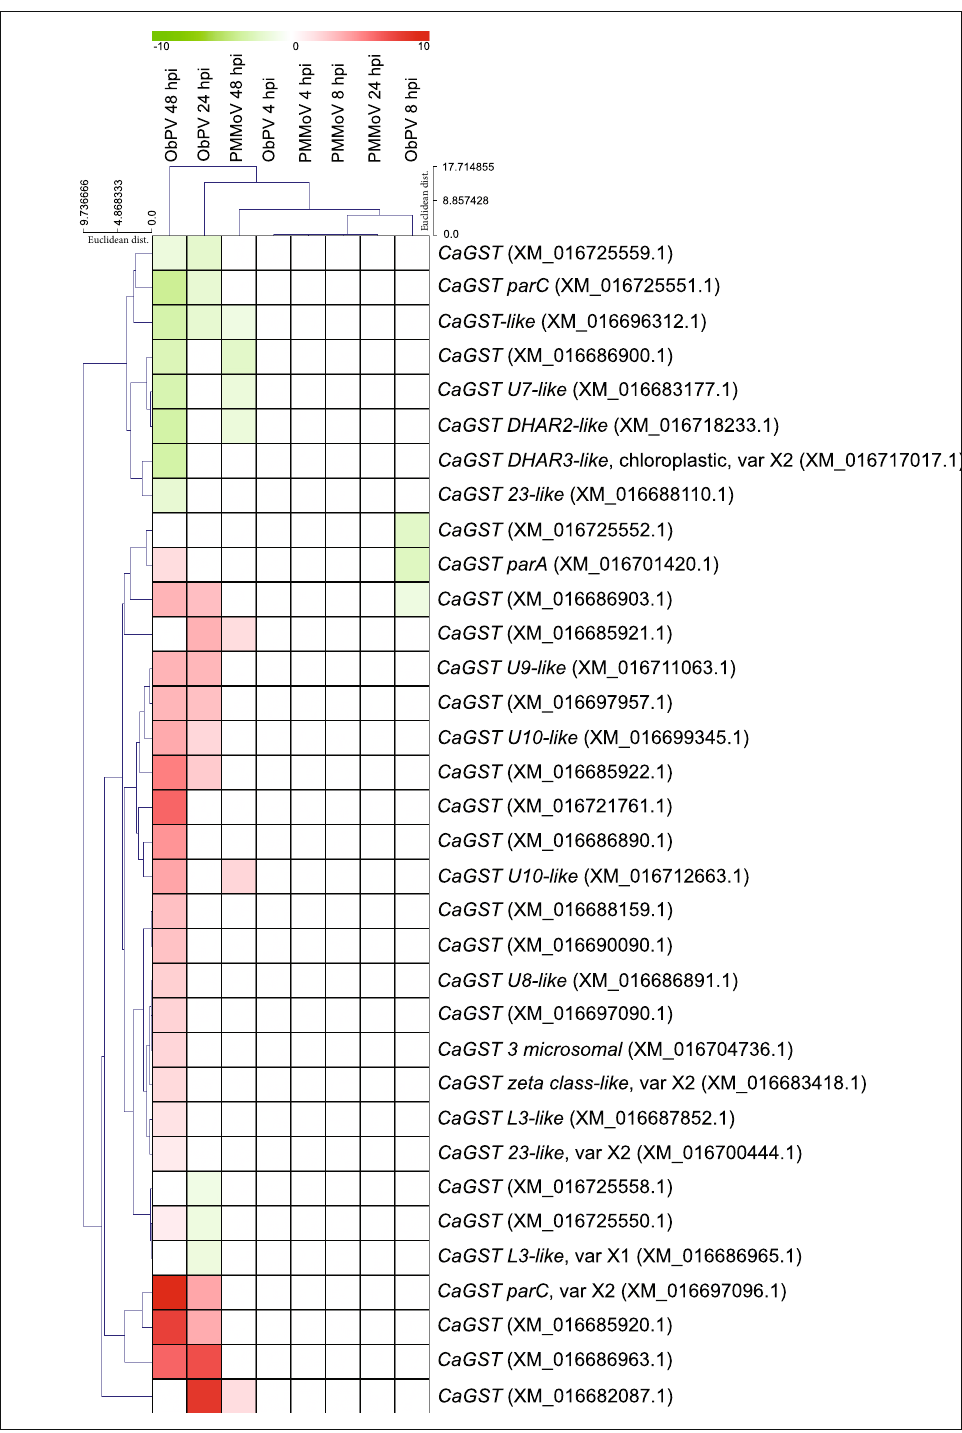
Figure 5. Heat-map representing changes in the expression of 34 glutathione S-transferase ( GST ) genes in pepper leaves inoculated with Obuda pepper virus (ObPV) and Pepper mild mottle virus (PMMoV) at 4, 8, 24 and 48 h post-inoculation (hpi). Euclidean distance based hierarchical clustering was performed with average- linkage both among each of the GSTs and